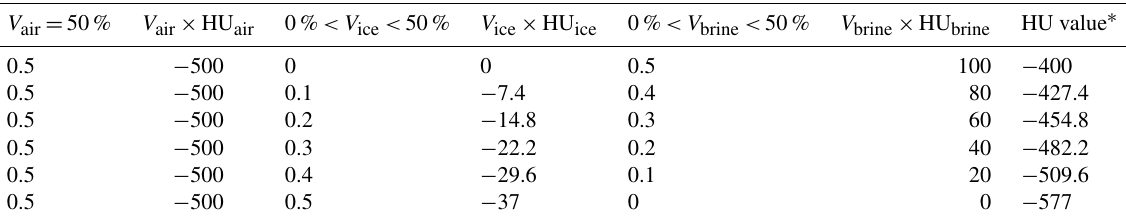
Table 2. Estimation of the HU value of a pixel containing at least 50% of air. Assuming the HU value of air, of ice and brine are − 1000, − 74 and 200, respectively.